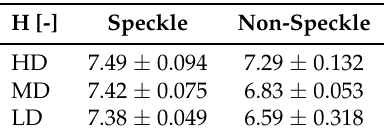
Table 2. Image Shannon entropy H mean and standard deviation values of each foam grade, speckled and non-speckled.